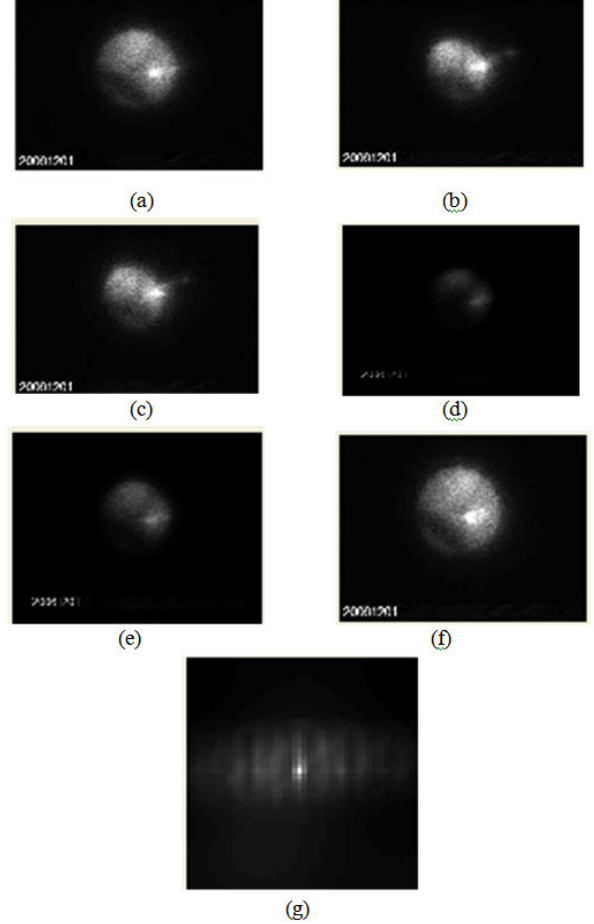
Fig. 2 Restoration of a real degraded AO image: (a) first frame, (b) second frame, (c) third frame, (d) image restoration using the Wiener-IBD algorithm, (e) image restoration using the RL-IBD algorithm, (f) image restoration using our algorithm, and (g) estimated PSF by our